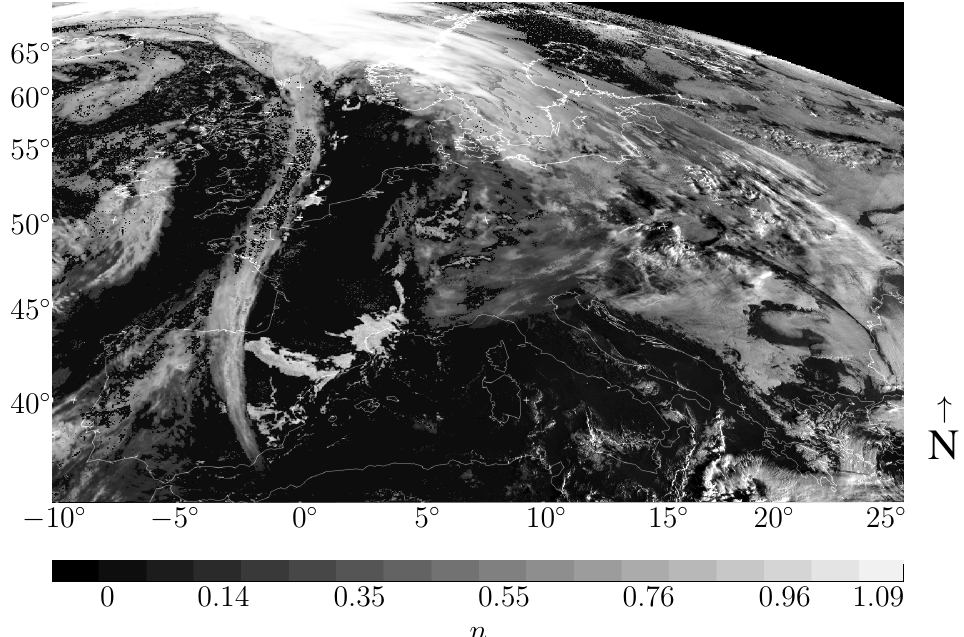
Figure 8. Combined cloud index image for Europe, 1 November 2014, 0600